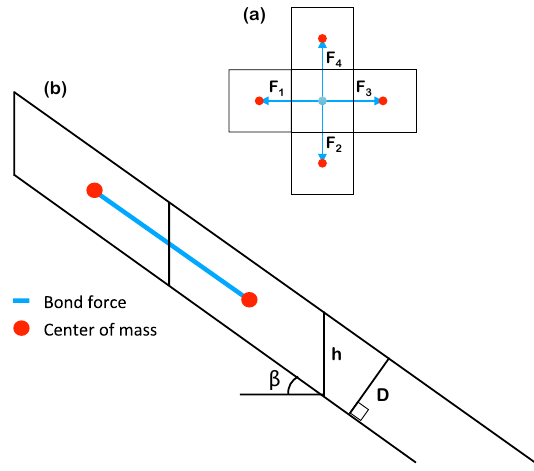
Figure 1. (a) Plan view of discretized cell with its four neighbors showing bond forces. (b) Vertical section across neighboring cells showing the center of mass of cells and the location of the connect- ing bond. β is the surface slope and h and D are the thicknesses of soil down to the basal surface, measured vertically and perpendicu- lar to the surface,